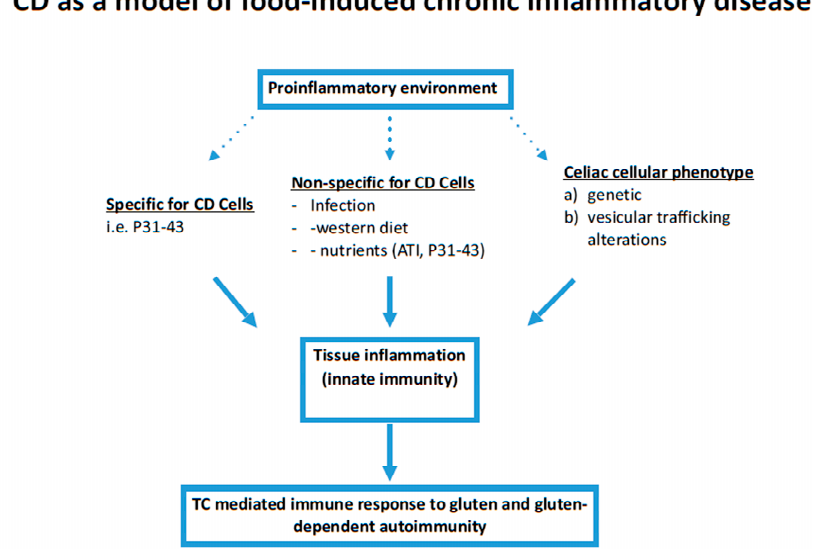
Figure 1. Role of the pro-inflammatory environment and tissue inflammation in CD. Pro-inflammatory environment has an important role in CD pathogenesis. It can be induced by external factors that can be specific for CD cells such as the A-gliadin peptide P31–43, or not specific (infections, diet, other wheat components etc.), but it can also be constitutive in the CD cells.